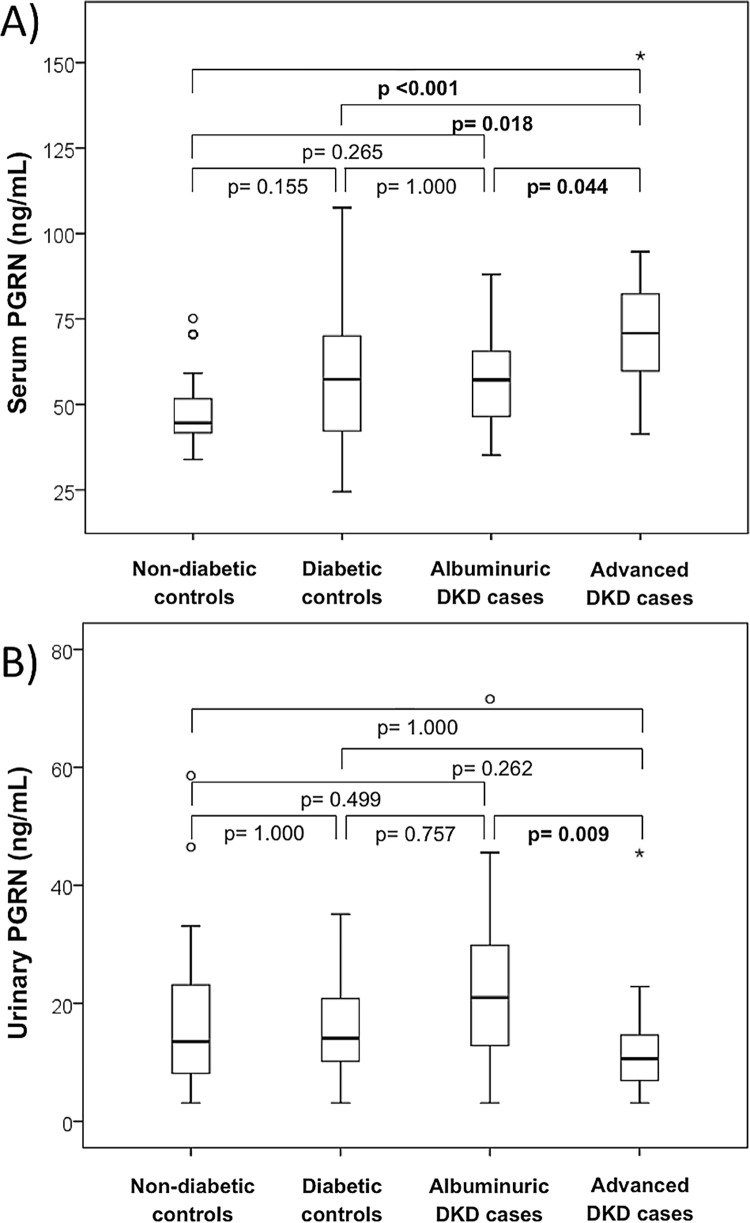
Boxplots showing serum (A) and urinary (B) levels of PGRN (ng/mL) according to study groups. PGRN: progranulin; DKD: diabetic kidney disease.